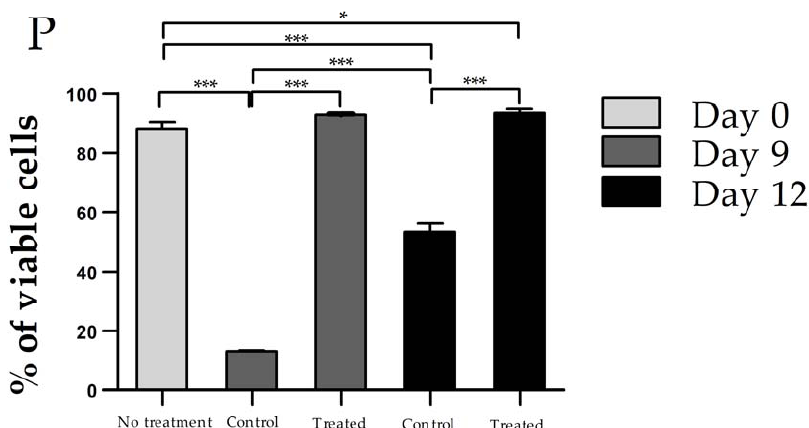
Figure 4. Cell viability images, using live/dead staining of bioprinted constructs on day 0 ( A – C ), day 9 for the control group ( D – F ) and experimental group ( G – I ), and day 12 for control ( J – L ) and experimental group ( M – O ). Images were quantified and values are given as average ± standard deviation ( n = 3). One-way ANOVA and Turkey post-hoc analysis was conducted, using a confidence level of 95%; * p < 0.05; *** p < 0.001. Scale bar represents 100 µ m for ( A – I ) and 1 µ m for ( J – O ). ( P ) shows quantification of the viable cells present in the constructs at Day 0, 9, and 12.